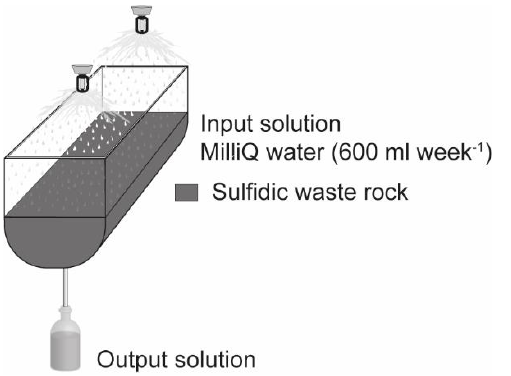
Figure 1. Experimental design of small-scale test cells filled with sulfidic waste